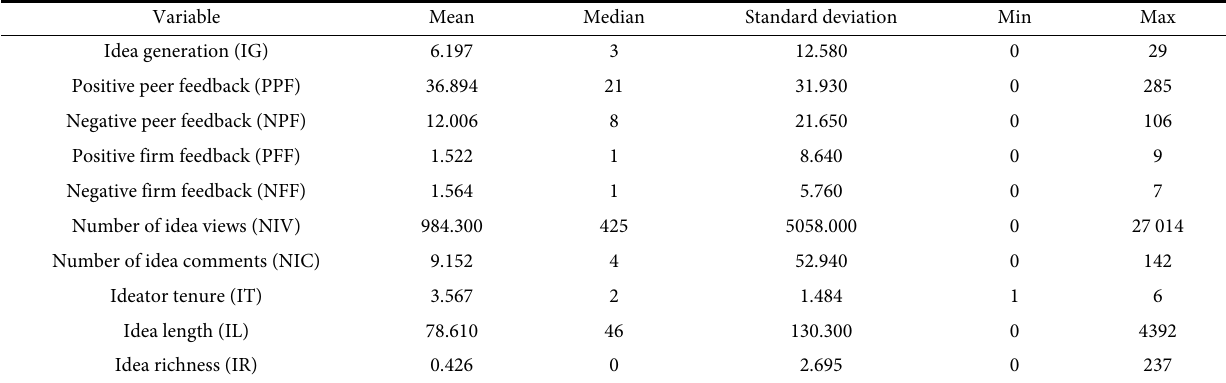
Table 1 Descriptive statistics of